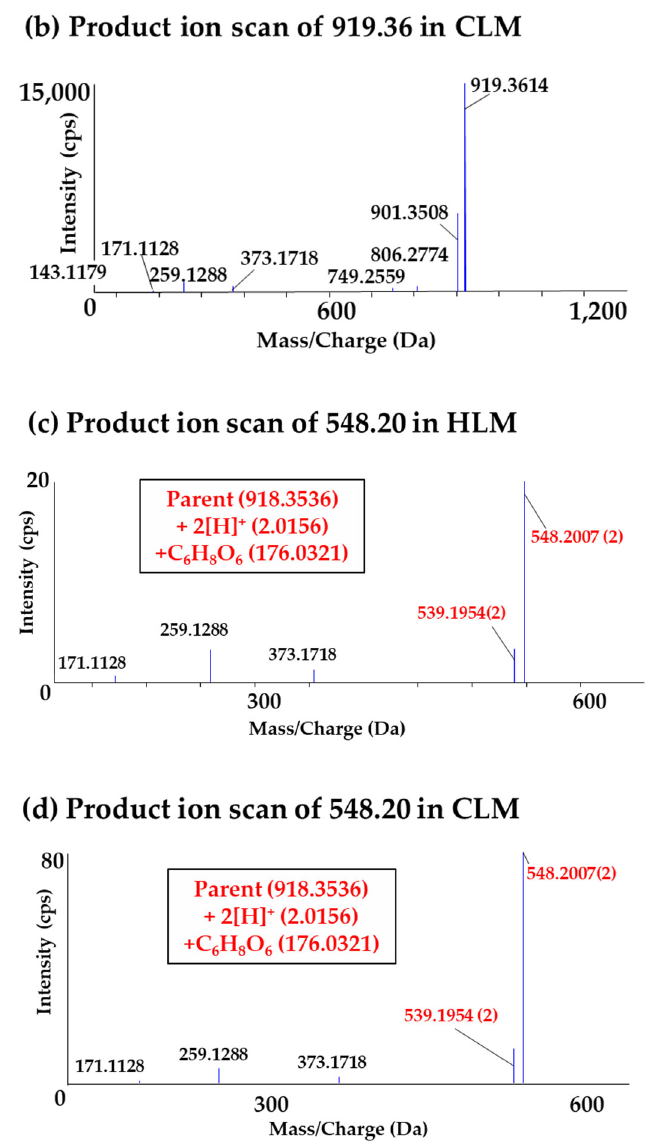
Figure 7. Identification of in vitro glucuronide metabolite of α‐ amanitin. ( a ) Product ion scan of α‐ amanitin in HLM ( m/z 919.36); ( b ) product ion scan of α‐ amanitin in CLM ( m/z 919.36); ( c ) product ion scan of a glucuronide metabolite in HLM ( m/z 548.20); ( d ) product ion scan of a glucuronide metabolite in CLM ( m/z 548.20).